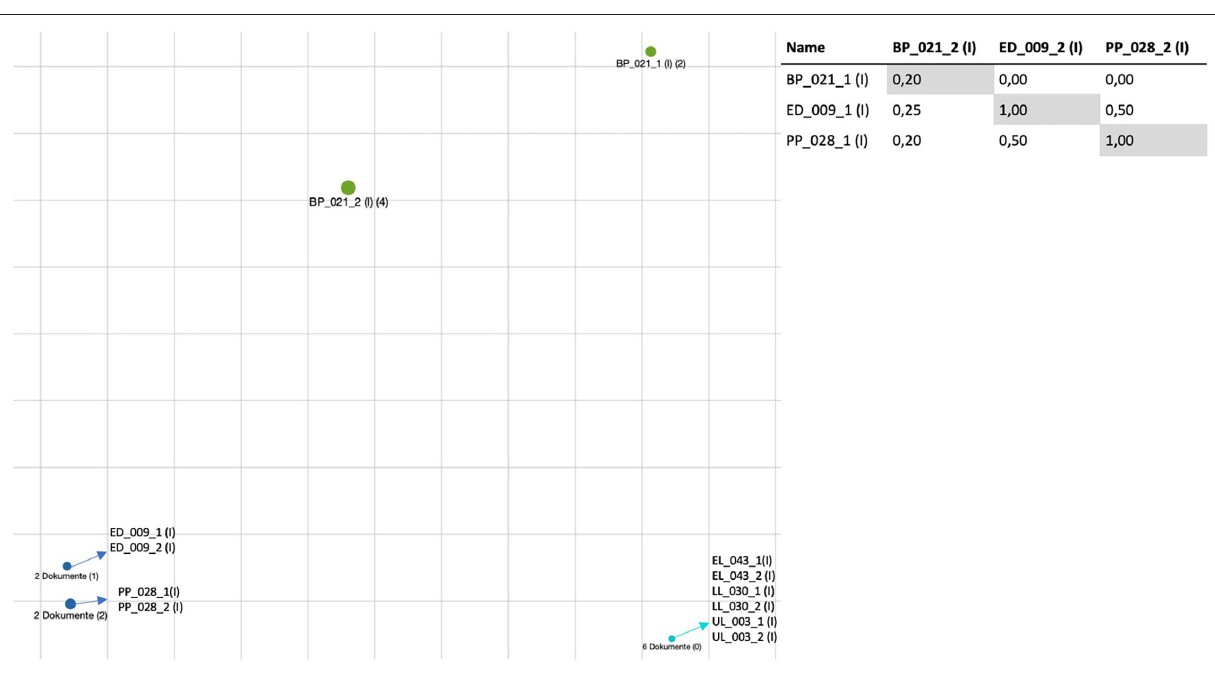
FIGURE 7 | (Left): Similarity map based on Jaccard’s Coefficient for all non-leaders in the emoji condition, emoticons only. The distance between the individuals’ text excerpts reflects the respective degrees of similarity. (Right): The closer the result is to 1, the more similar the parts of the chats are to each other. Gray indicates “correct”